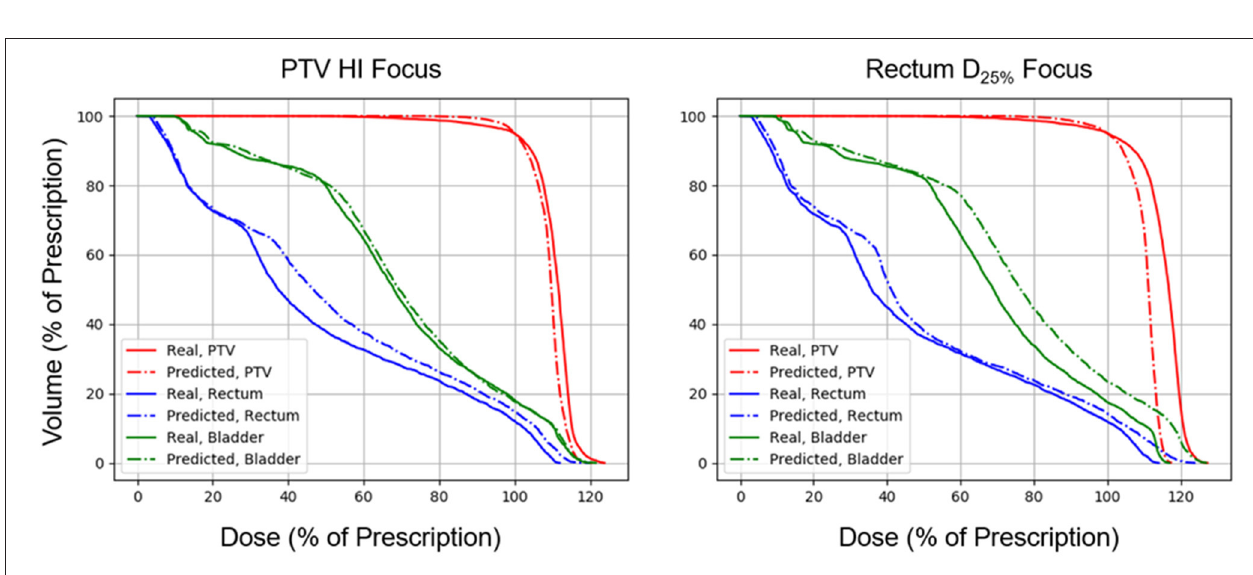
Predicted Pareto Surface Evaluation The mean Pareto space RMSEs were 10.33 ± 3.57% and 10.11 ± 4.61% for the training and testing sets, respectively, when aggregated over the fifty splits of 10-fold cross-validation.